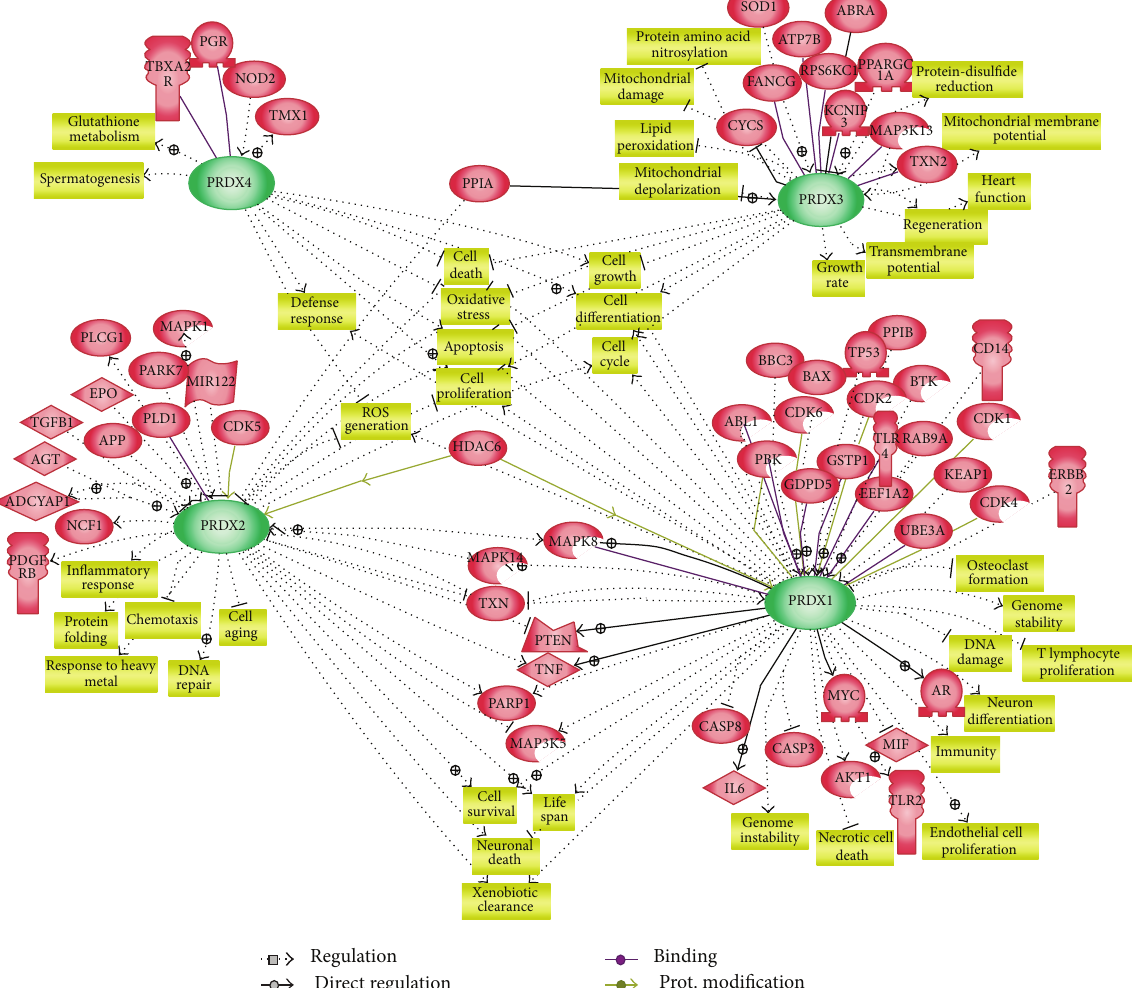
Figure 3: Summary of regulatory networks centered by typical 2-Cys Prxs. Functional correlation and interaction among the signaling proteins and typical 2-Cys Prxs are reconstituted into a network model using the Pathway Studio software (Ariadne Genomics Inc., USA). All molecules are shown as gene symbol. Direct and indirect regulations were indicated in gray lines and dotted gray lines, respectively. Green arrows indicate regulation by protein modifications. Purple lines indicate direct protein-protein